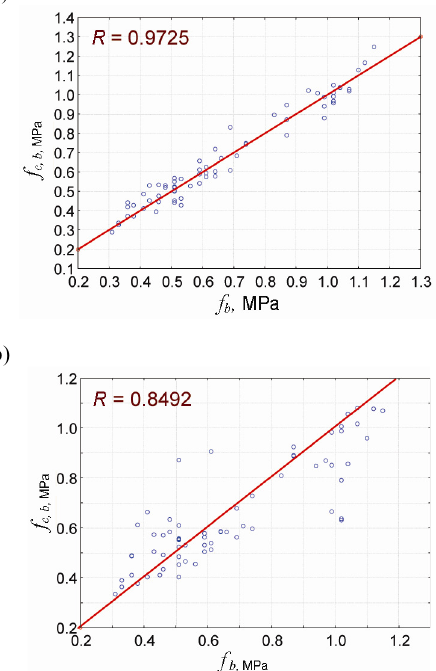
Fig. 11. Correlation between pull-off adhesion f b experimentally determined by seminondestructive pull-off method and pull-off adhesion f c.b identified by network C in testing for data acquired by three nondestructive techniques (a) and by two nondestructi- ve techniques